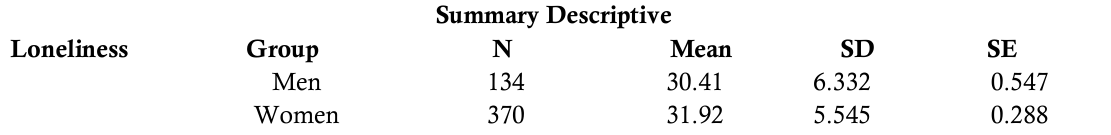
Table 2. Descriptives comparation man and woman